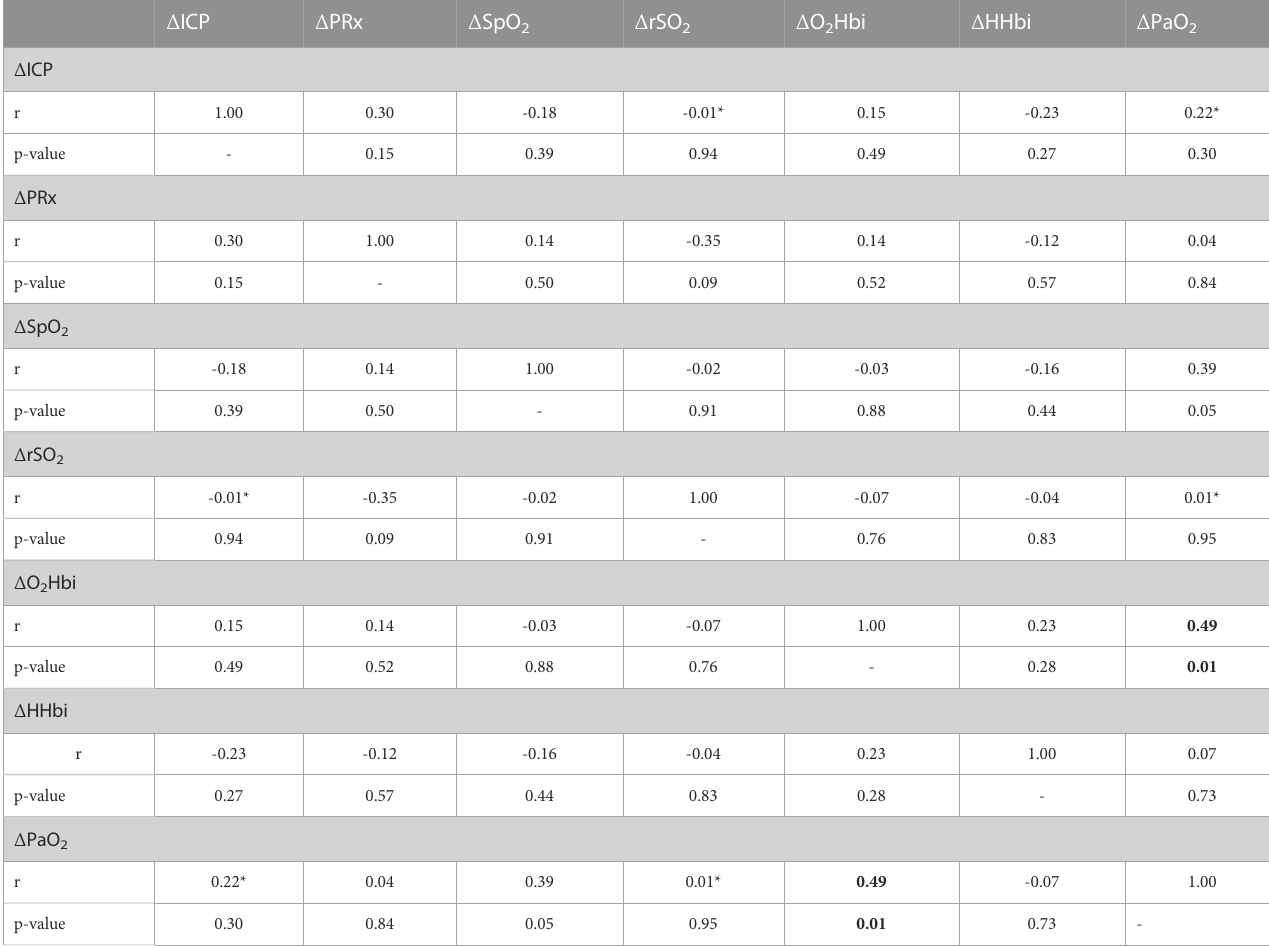
TABLE 3 Correlation between changes( Δ ) in systemic and neuromonitoring parameters.